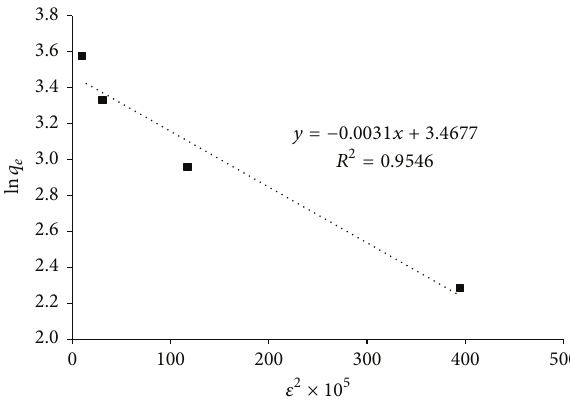
Figure 11: Temkin isotherm (pH = 5.6, 𝐶 0 = 5–20 mg/L, dose = 0.5 g/L, contact time = 180min, and temperature = 30 ∘ C).